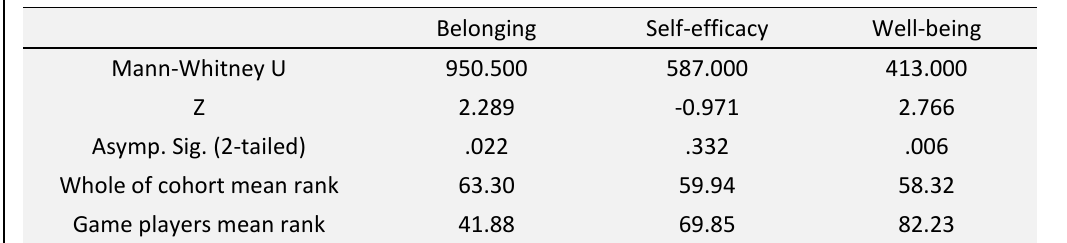
Mann-Whitney U test for responses prior to the game (whole of cohort) and immediately after the game (game players